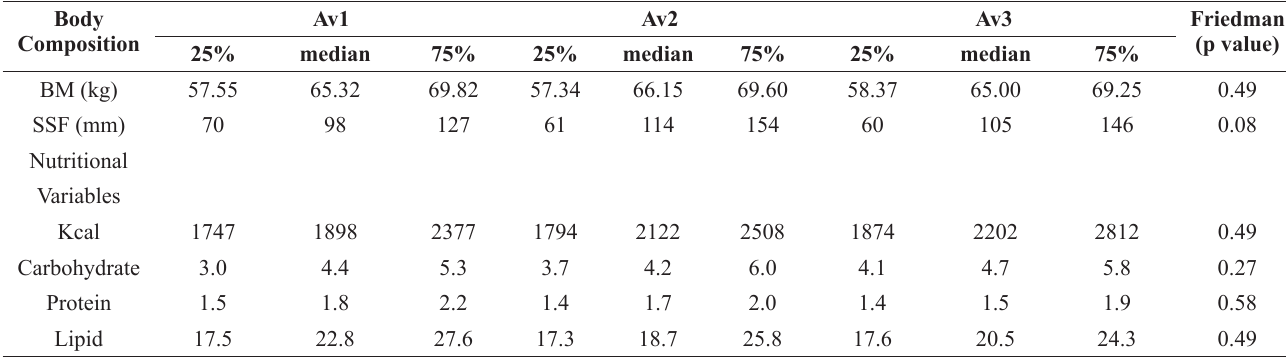
Table 5. BM, SSF, kcal and macronutrients intake among three evaluations. Body